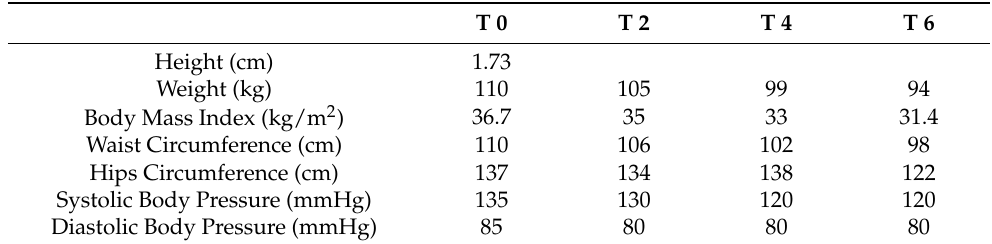
Table 1. Anthropometric measurements of the patient at baseline (T0), every 2 weeks (T2 and T4), and at the end (T6) of